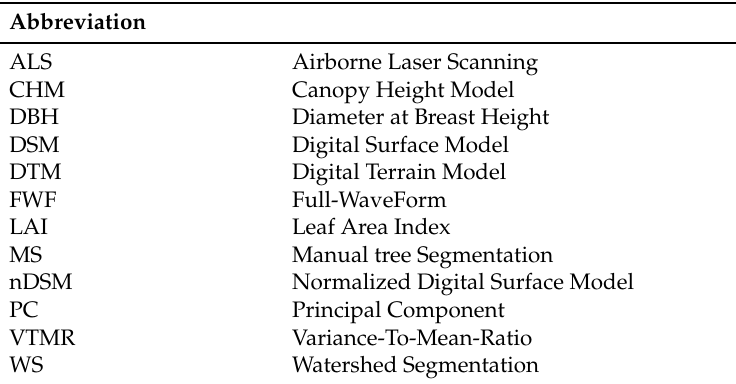
Table A1. Common